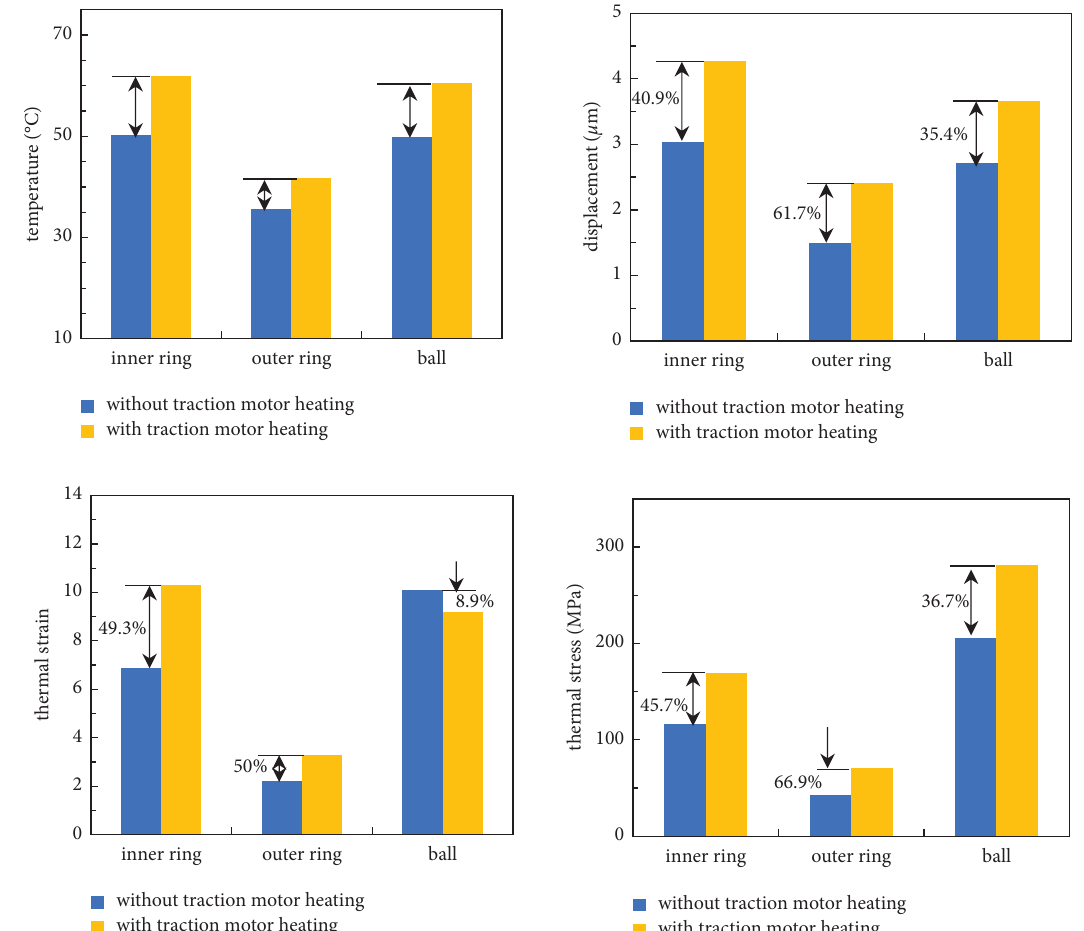
Figure 12: Comparison of thermal stress and comprehensive stress of traction motor